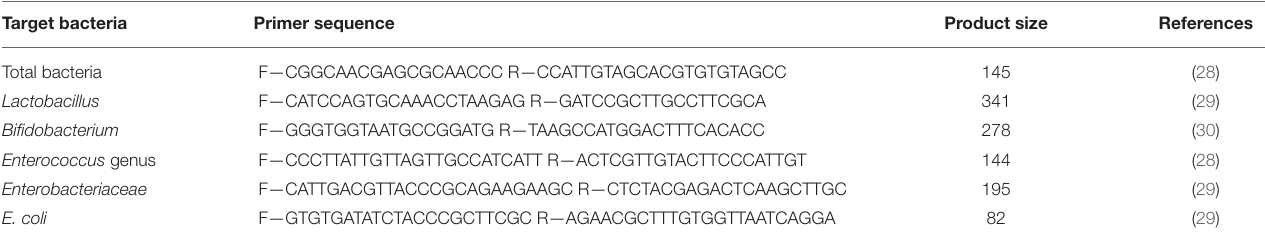
TABLE 3 | The DNA primer sequences of target bacteria.